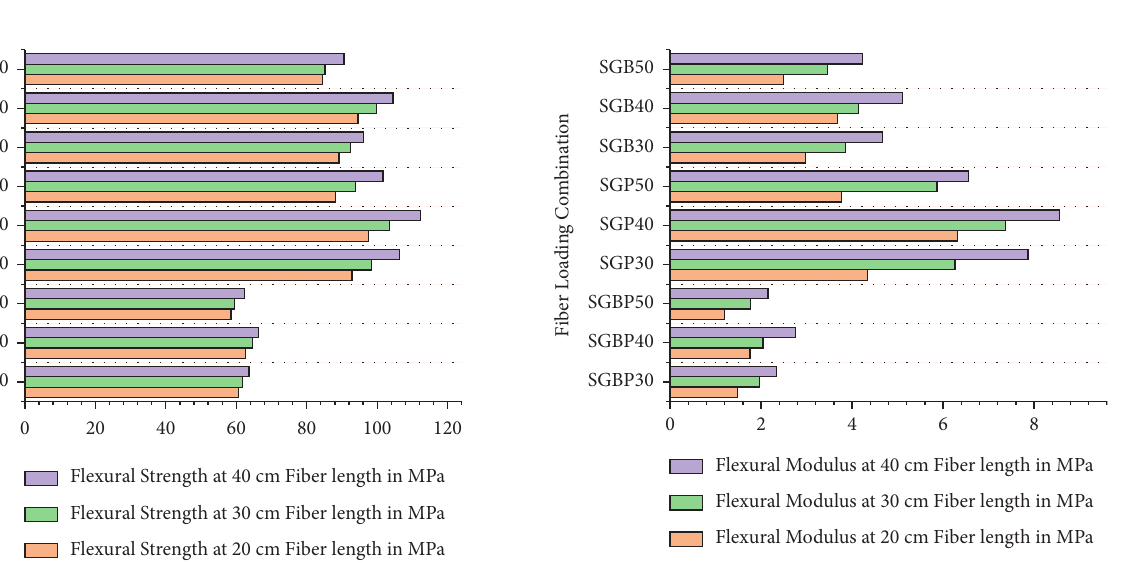
Figure 3: Graphical representation of flexural strength for various samples at different fiber volumes and fiber lengths.